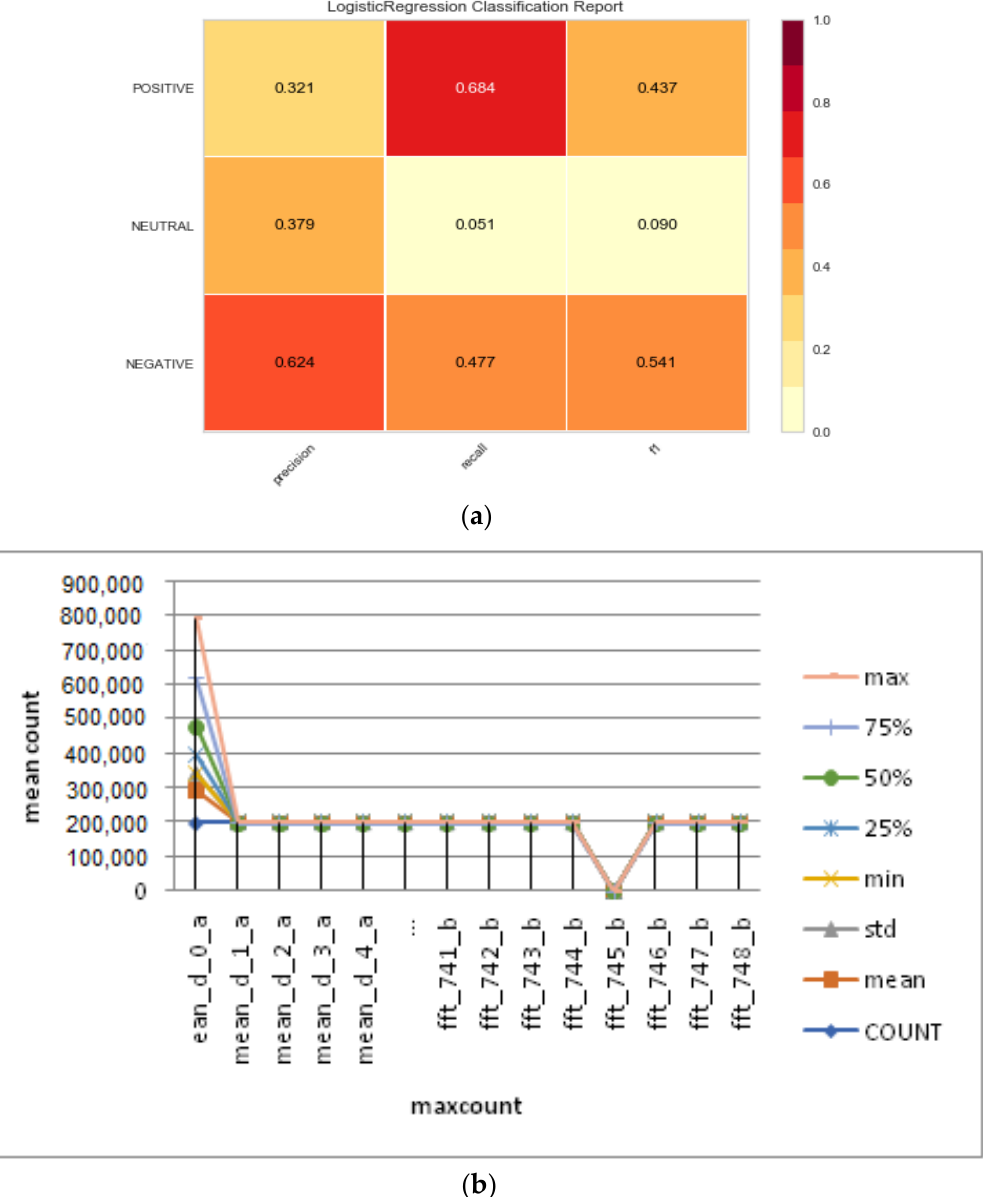
Figure 11. ROC graph of logistic regression classifier on Deep dataset. Table 3 shows the different parameters used for the analysis of the proposed method, along with others. Concerning architecture complexity, without enough internal complex- ity to keep it running and maintain its structural integrity, the system as a whole would not exist. The visual surface information of some man-made architectural designs is kept low for stylistic reasons; however, hiding complexity is not being honest about the design. In architecture, what do simplicity and complexity mean? It is very difficult to generate pure simplicity or pure complexity without the necessity for them to coexist because sim- plicity and complexity are typically seen as the two extreme ends of the same continuum. Typically, the word “simplicity” is used to describe architecture. How long memory can persist without being retrieved is determined by a long-term memory characteristic called stability of memory. The probability of forgetting in a given amount of time depends on stability (the higher the stability, the less the probability). Qualitative data is not based on formal structures because it is non-statistical and frequently semi- or unstructured. It is not always necessary to quantify these data to produce graphs and charts. Instead, it is